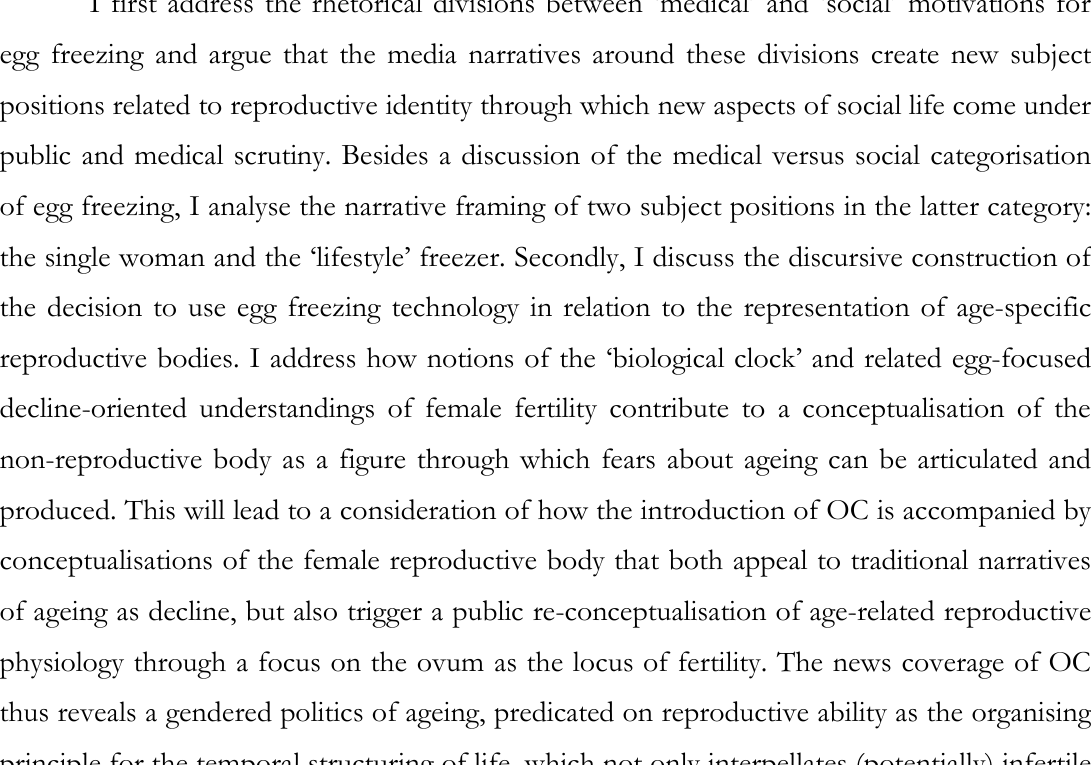
Lucy van de Wiel, For Whom The Clock Ticks: Reproductive Ageing and Egg Freezing in Dutch and British News